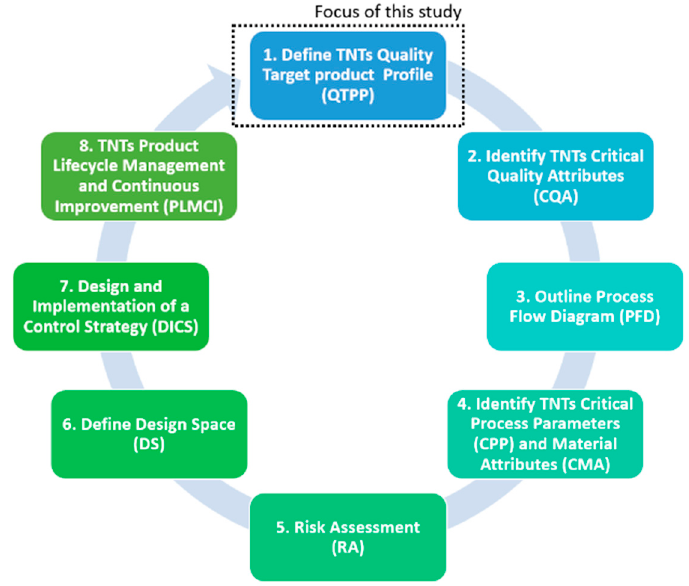
Figure 1. Schematic showing the focus of this study within the QbD system.